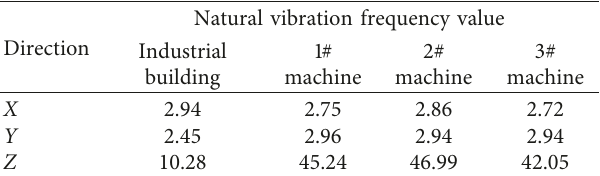
Table 2: Test results of self-vibration characteristics for machines and industrial